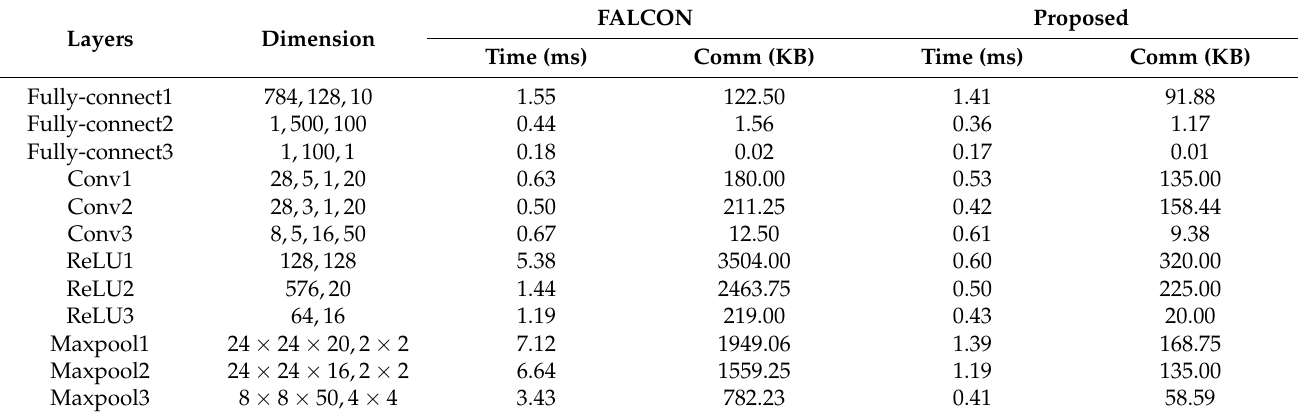
Table 3. Microbenchmarks in semi-honest